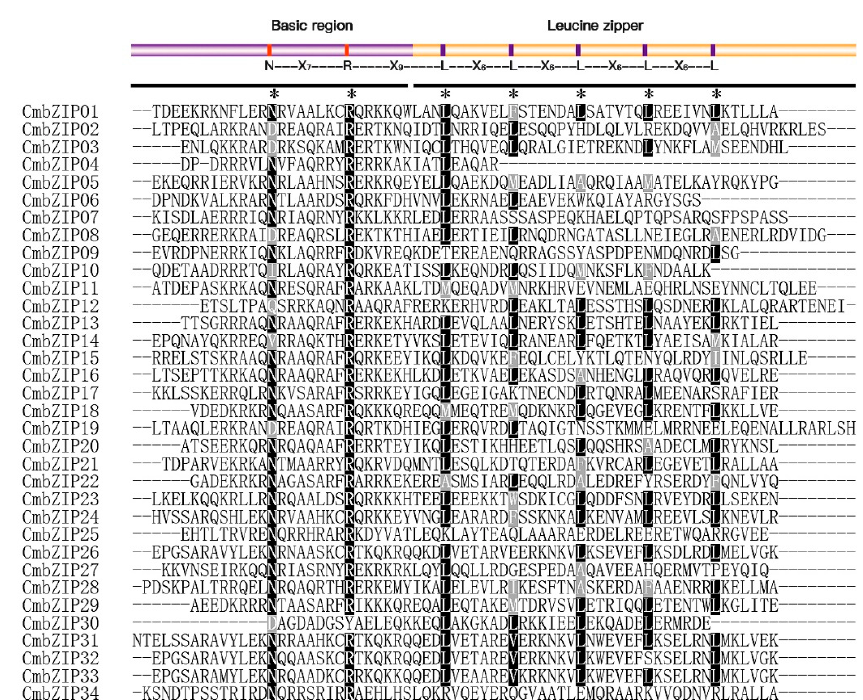
Figure 1. Multiple sequence alignment of CmbZIP domains. Amino acid sequences of CmbZIP domains are aligned by MUSCLE V3.8.1551 with minor modifications. The model and invariant of the basic region and leucine zipper are shown in the upper part. Asterisks show the conserved amino acids of bZIP domain. White letters in black shadow indicate conserved amino acid residues in right position, and gray shadow is for the position replaced by other less conserved amino acids.